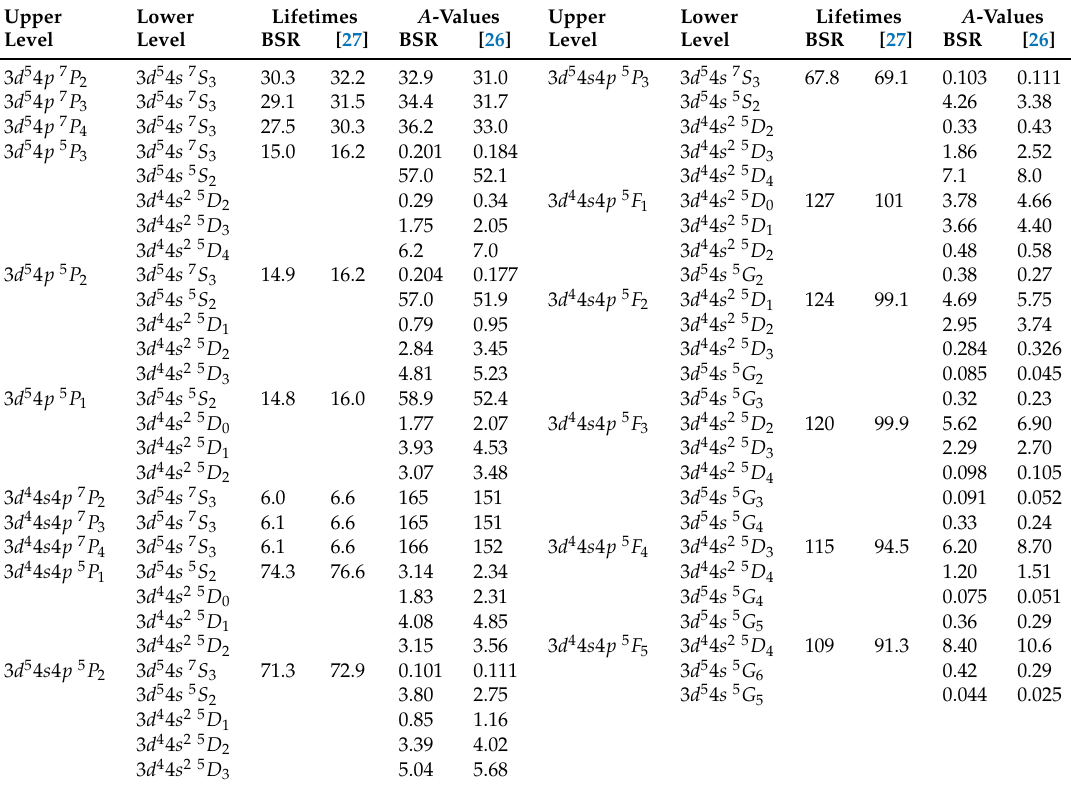
Table 2. Comparison of lifetimes (ns) and transition probabilities (10 − 6 s − 1 ) for some E1 lines of Cr I.